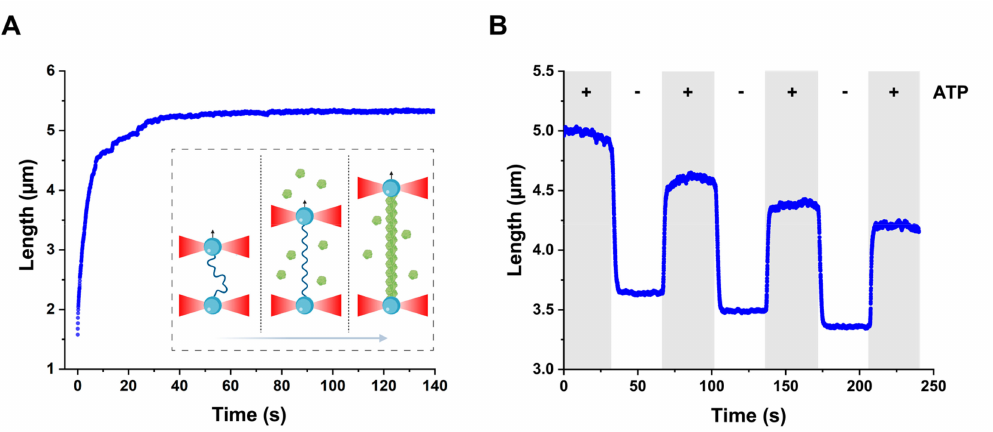
Figure 1. Dynamics of DrRecA–ssDNA filaments length. ( A ) DrRecA binding leads to ssDNA elongation under the stretching force of 12 pN (Inset: schematic representation of the experimental scheme. A DNA tether is stretched with a controlled force by adjusting the distance between the beads using dual-trap optical tweezers). ( B ) DrRecA–ssDNA filaments reversibly switch between stretched and compressed conformations depending on the presence of ATP, which is characterized by dynamic change of the filaments length at stretching force of 2 pN in the ATP-containing bu ff er (gray sections) and ATP-free bu ff er (white sections). DrRecA: a central enzyme of recombinational DNA repair; ssDNA: single-stranded